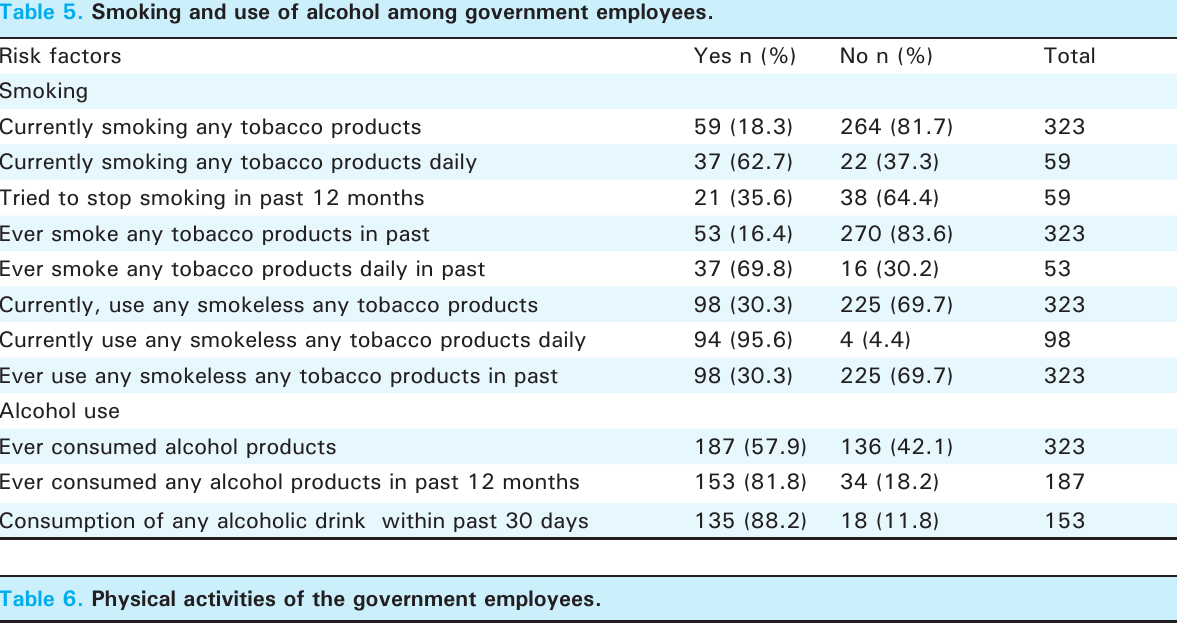
Table 5. Smoking and use of alcohol among government employees.